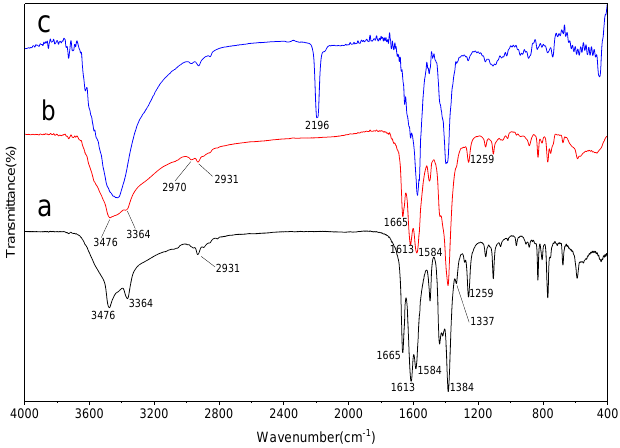
Figure 1. FT-IR spectra of ( a ) Cu(BDC-NH 2 )(DMF), ( b ) Et- N -Cu(BDC-NH 2 ) (DMF) and ( c ) Et- N -Cu(BDC-NH 2 )(DMF)-Pd(CN) 42 − .